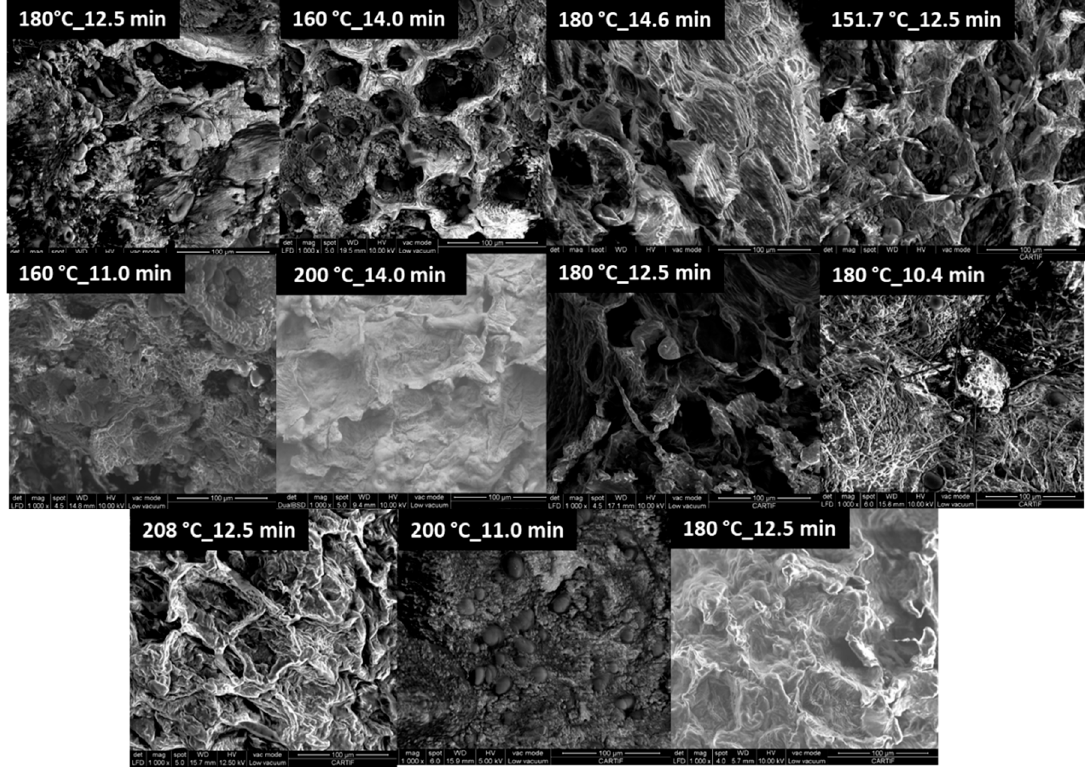
Figure 7. Scanning Electron Microscopy (SEM) for the snacks processed following the temperature and time RSM design. time RSM